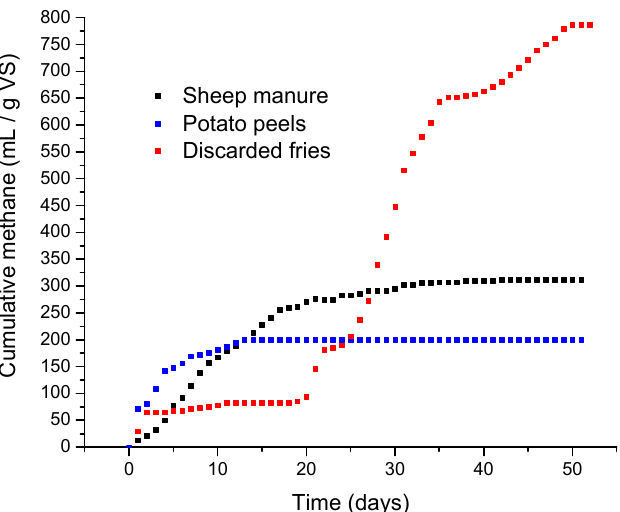
Figure 2. Cumulative methane curves obtained from mesophilic batch tests (BMP tests). Substrates tested were sheep manure, potato peel waste, and discarded chips.